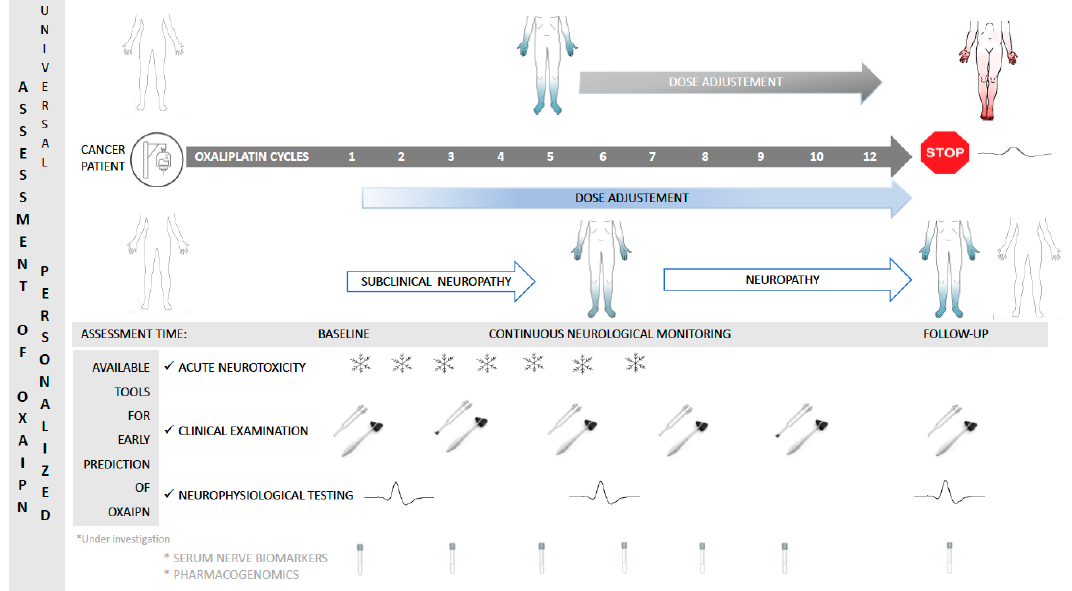
Figure 1. Personalized assessment of neuropathy by present and future strategies to early detecting and monitoring oxaliplatin-induced peripheral neuropathy in gastrointestinal cancer patients.